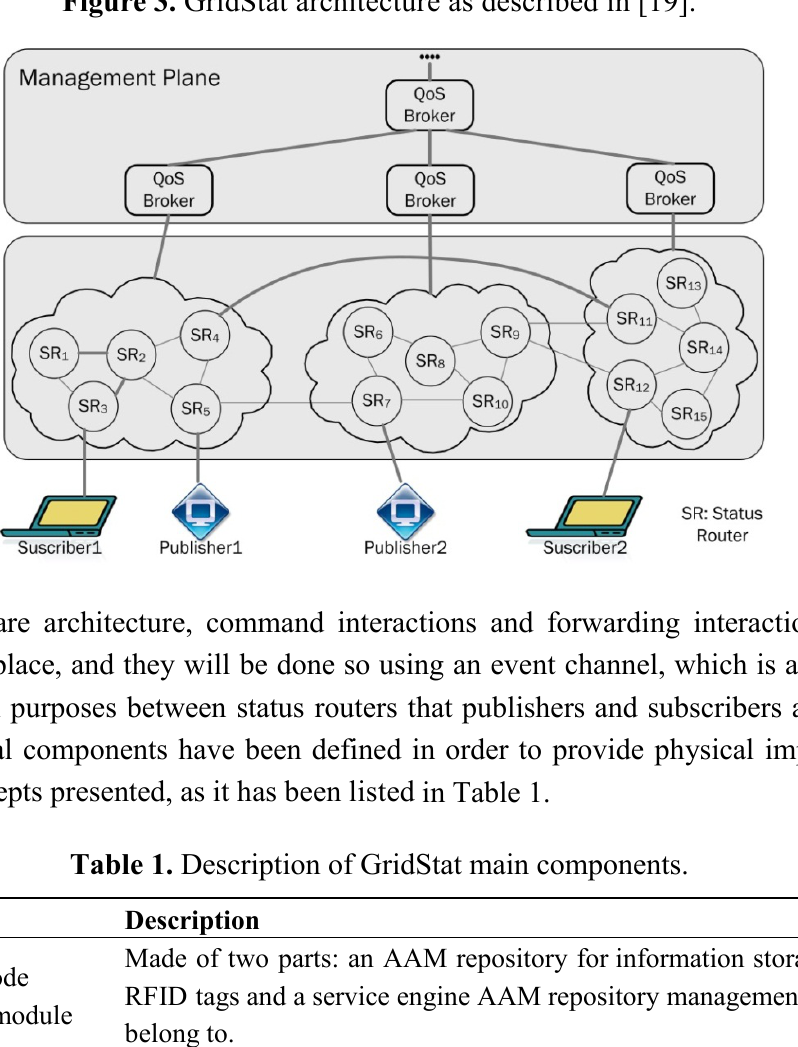
Figure 3. GridStat architecture as described in [19].